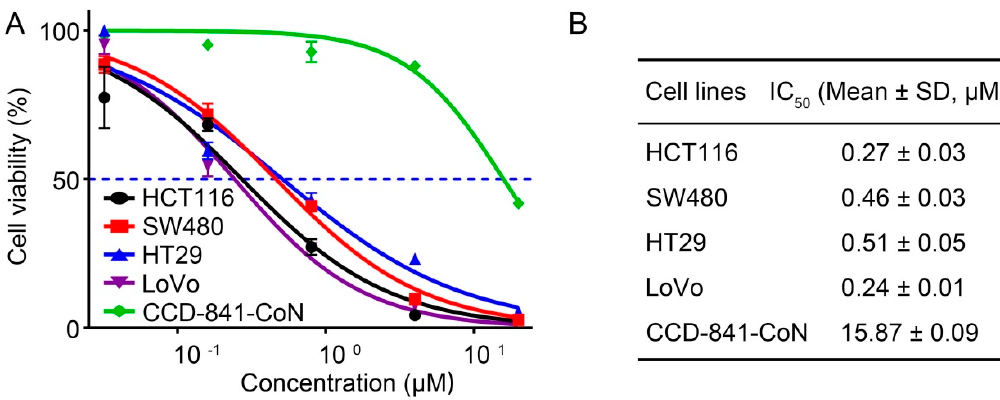
Figure 4. 4 β HWE selectively suppresses the proliferation of CRC. ( A ) The proliferation inhibition of 4 β HWE on CRCs, including four colorectal cancer cell lines (HCT116, SW480, HT29, and LoVo) and CCD-CoN-841, a normal human colonic epithelial cell line, was determined by MTS assay. Cells were treated with 4 β HWE for up to 48 h. ( B ) The median inhibition concentration (IC 50 , 48 h) values of 4 β HWE for various cell lines were calculated.